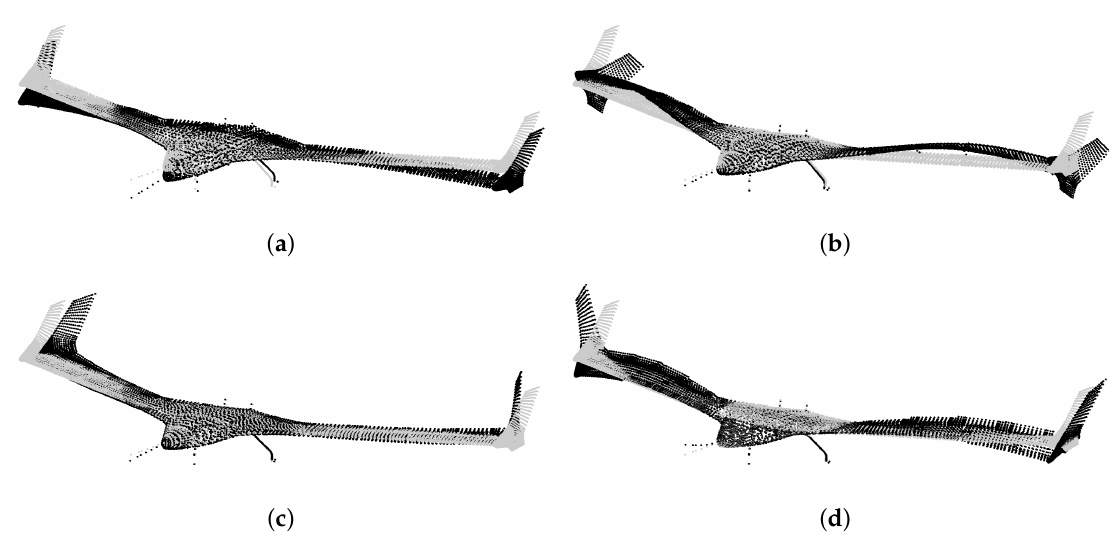
Figure 2. Longitudinal in-vacuo mode shapes for the X-56A (FEM configuration 24611, version 10.424_dev, 50% fuel). Gray markers are the undeformed grid points and black markers are the deformed points. ( a ) Mode 7: First symmetric wing bending (SW1B). ( b ) Mode 9: First symmetric wing torsion (SW1T). ( c ) Mode 10: Symmetric fore-aft (SFA). ( d ) Mode 14: Symmetric winglet lateral